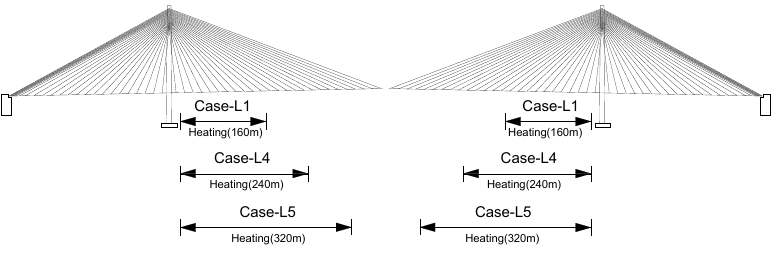
Table 8. Temperature rises and heating lengths for various elongation lengths.